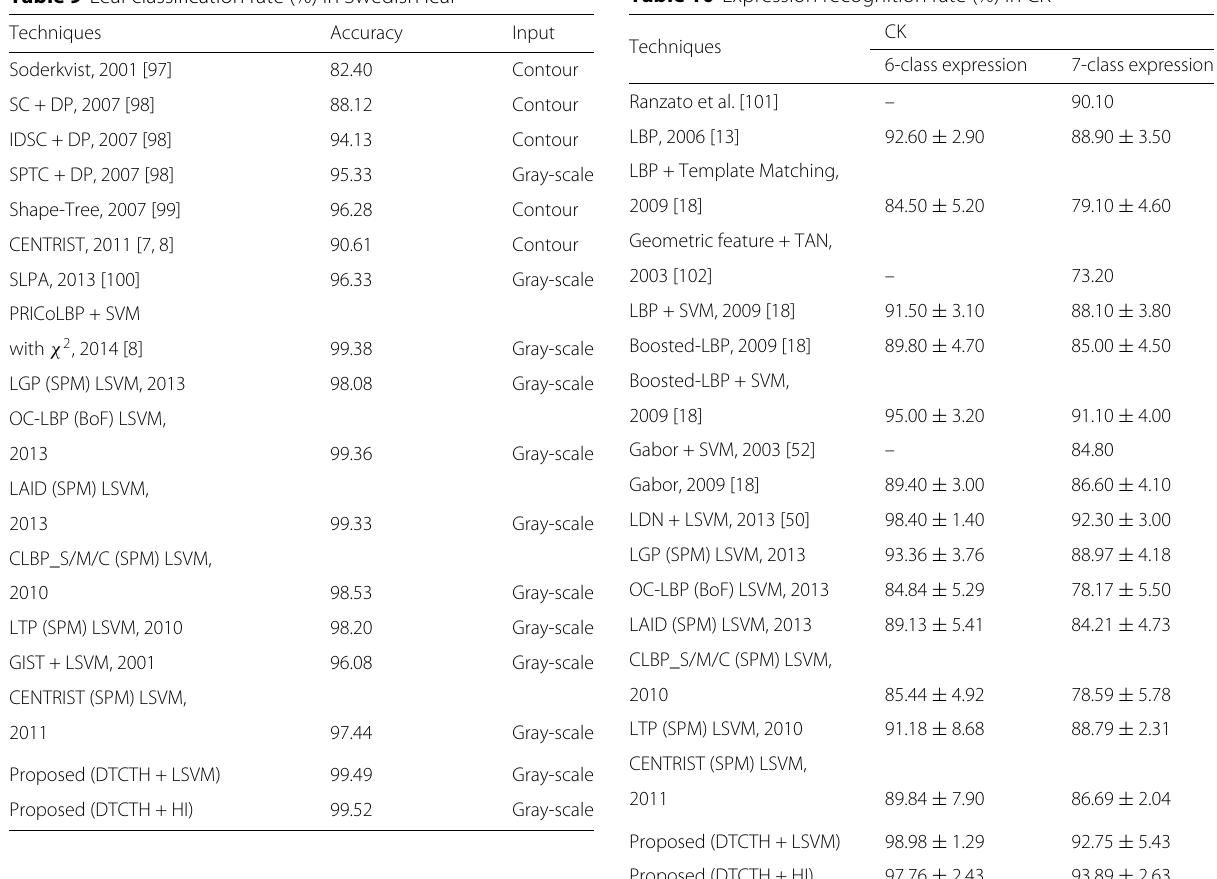
Table 9 Leaf classification rate (%) in Swedish leaf Table 10 Expression recognition rate (%) in CK